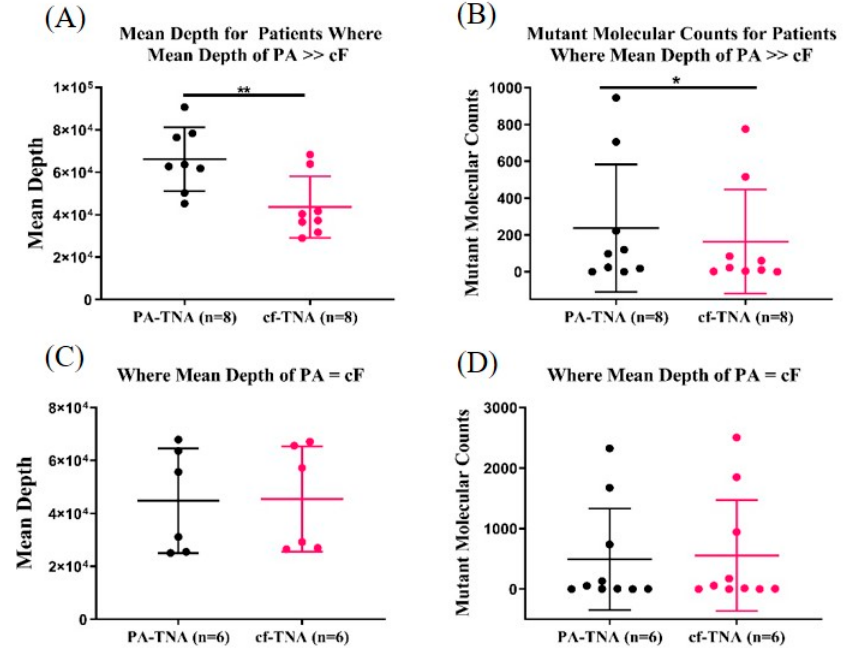
Figure 4. Improved NGS performance correlates to increased mutant molecular count in PA. Mutant allele detection was compared in PA-TNA or cf-TNA extracted from EDTA plasma from matched NSCLC patients and sequenced by Next Generation Sequencing using an Oncomine Cell-Free Total Nucleic Acid panel. Samples were divided into two groups based on relative mean sequencing depth between paired PA-TNA and cf-TNA samples. The first group ( n = 8; * p < 0.05, ** p < 0.01) contained patient samples in which mean depth of PA-TNA was >10% higher than the paired cf-TNA sample ( A ) and the mutant molecular count for mutations detected within this group were compared ( B ). The second group ( n = 6) contained patient samples in which mean depth of PA-TNA was roughly equivalent (<10% difference) to the paired cf-TNA sample ( C ) and the mutant molecular count for mutations detected within this group were compared ( D ).